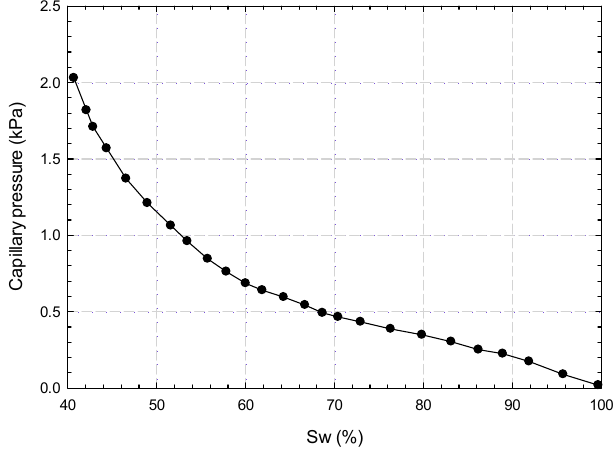
Figure 2. Capillary pressure curve in the heavy oil reservoir [42].